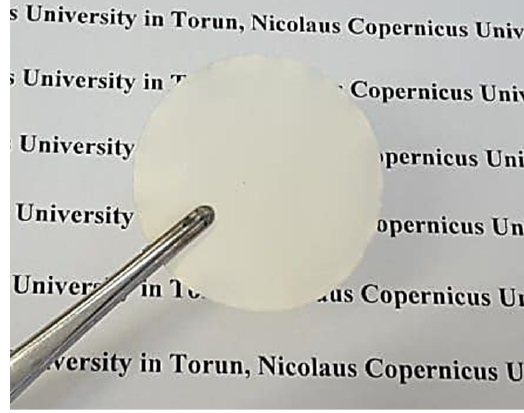
Figure 2. Image of obtained PA6 membrane. Table 1. Elaboration parameters of PA6 membranes.